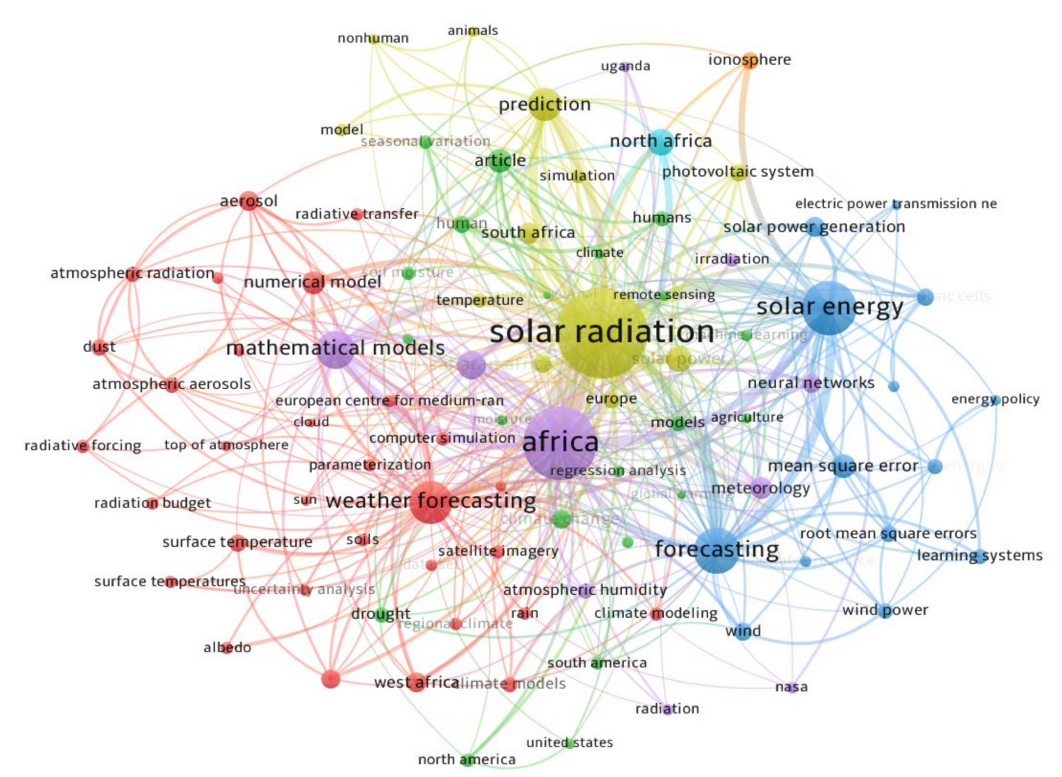
Figure 5. Keyword co-occurrences based on published documents in Africa.